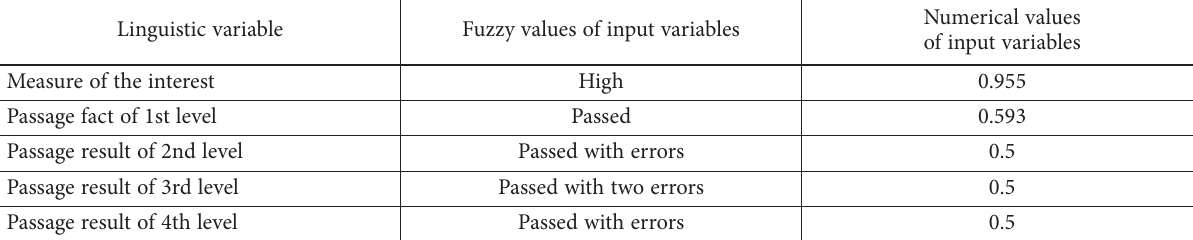
Table 3. The result of work FIS k ( k = 1, K